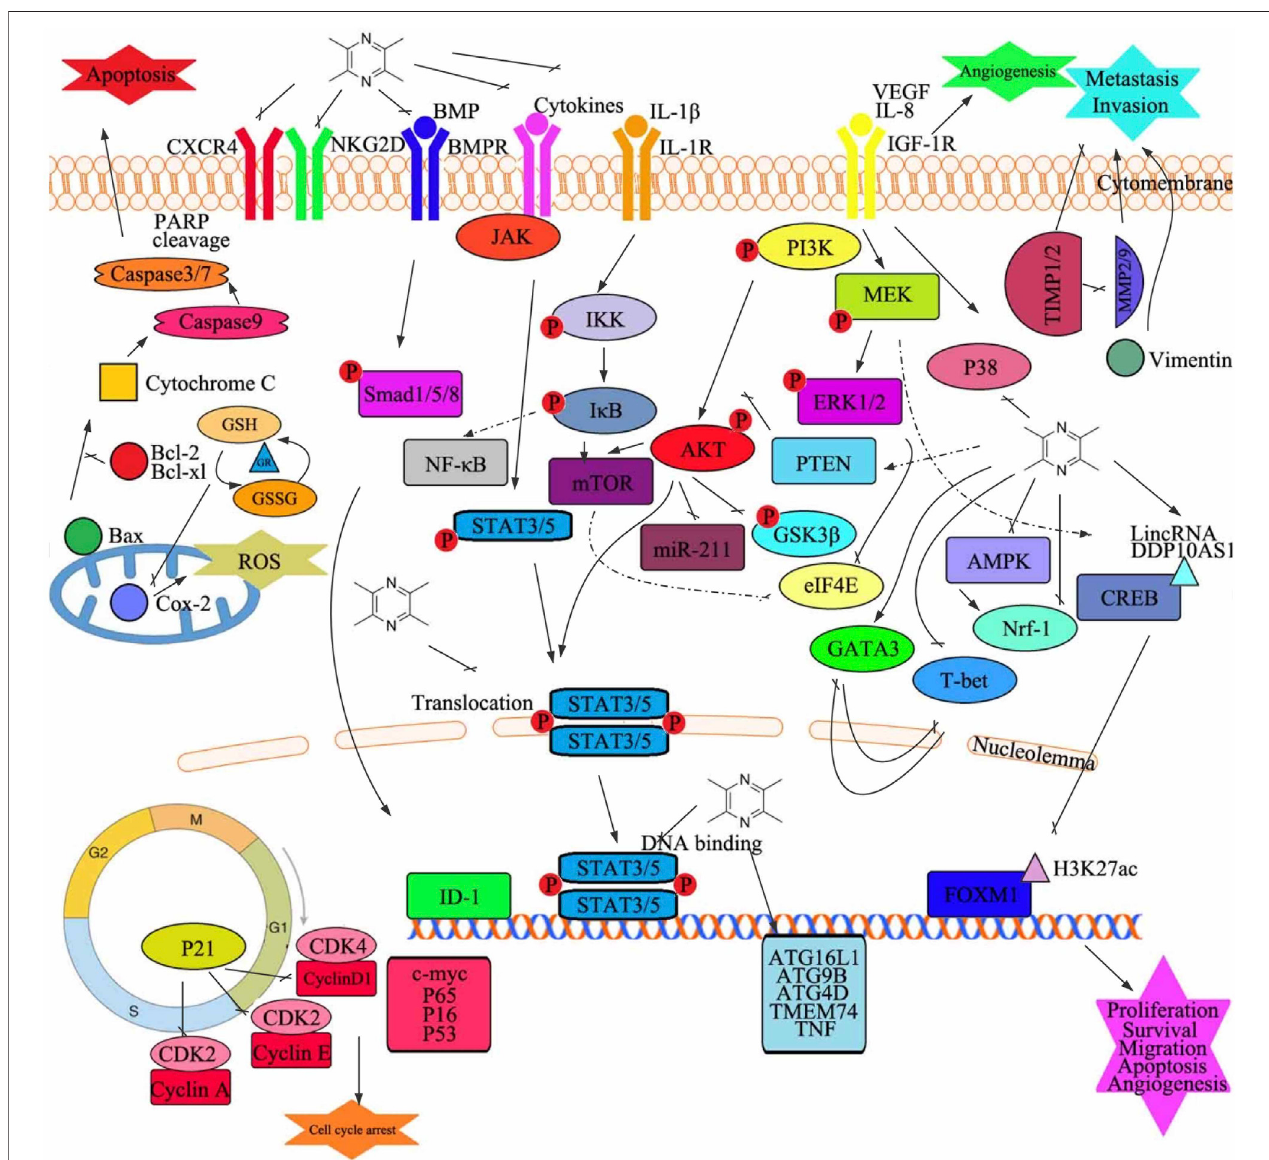
FIGURE3| Graphicalsummaryoftheantitumormechanismsunderlyingtheroleoftetramethylpyrazine.Tetramethylpyrazineactsonmultiplesignalingpathwaysin cancer cells to modulate several changes in phenotype such as cell proliferation, apoptosis, cell cycle arrest, migration, invasion, and angiogenesis. GSH, glutathione; GR, glutathione reductase; Bax, Bcl2-associated X protein; GSSG, oxidized glutathione; Cox-2, cytochrome c oxidase subunit II; ROS, reactive oxygen species; P, phosphorylation; NF- κ B, nuclear factor kappaB; STAT, signal transducer and activator oftranscription; CXCR4, C-X-C motif chemokine receptor 4; NKG2D, killer celllectin-likereceptorK1;BMP,bonemorphogeneticprotein;BMPR,bonemorphogeneticproteinreceptor;JAK,Januskinase;IL,interleukin;PARP,poly(ADP-ribose) polymerase; VEGF, vascular endothelial growth factor; IGF-1R, insulin-like growth factor 1 receptor; IKK, I-kappaB kinase; mTOR, mechanistic target of rapamycin kinase; miR, microRNA; PI3K, phosphatidylinositol 3-kinase; ERK, extracellular signal-regulated kinase; MEK, mitogen-activated protein kinase; PTEN, phosphatase and tensin; AKT, protein kinase B; GSK3 β , glycogen synthase kinase 3 beta; eIF4E, eukaryotic translation initiation factor 4E; GATA3, GATA-binding protein 3; T-bet, T-box transcription factor 21; Nrf-1, nuclear respiratory factor 1; CREB, DNA-binding transcriptional regulator CreB; AMPK, protein kinase AMP-activated catalytic subunit alpha 1; MMP, matrix metalloproteinase; TIMP, tissue inhibitors of metalloproteinase; ID-1, inhibitor of DNA binding 1; FOXM1, forkhead box M1; ATG4D, autophagy-related 4D cysteine peptidase; TMEM74, transmembrane protein 74; TNF, tumor necrosis factor; c-myc, transcriptional regulator Myc-like; CDK, cyclin- dependent kinases; ATG16L1, autophagy-related 16 like 1; ATG9B, autophagy-related 9B